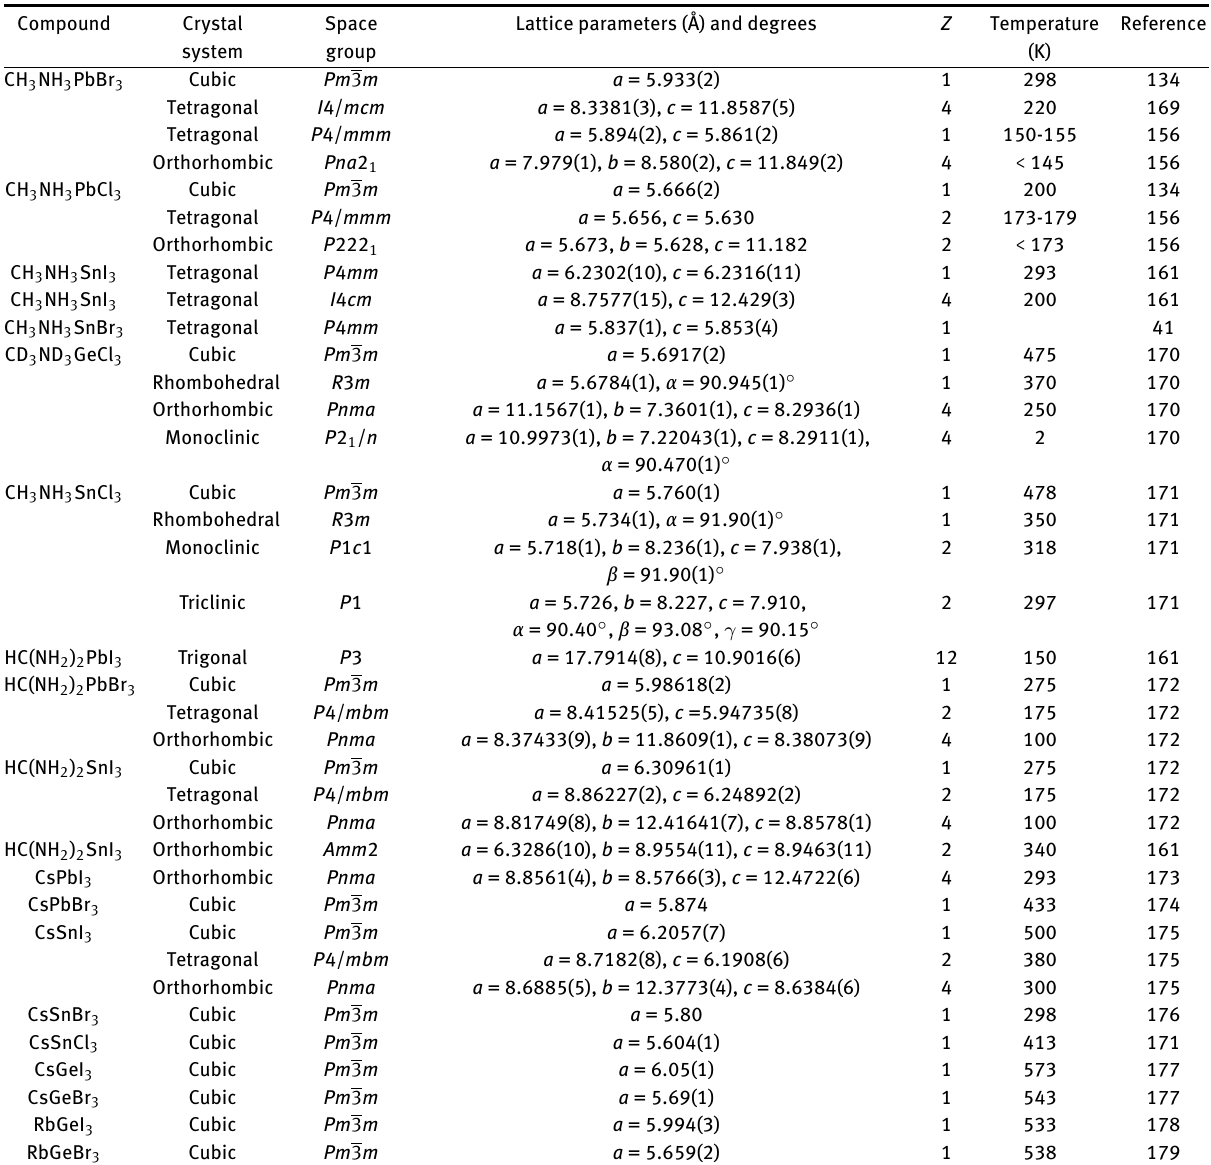
Table 11: Crystal systems of various perovskite halide compounds.